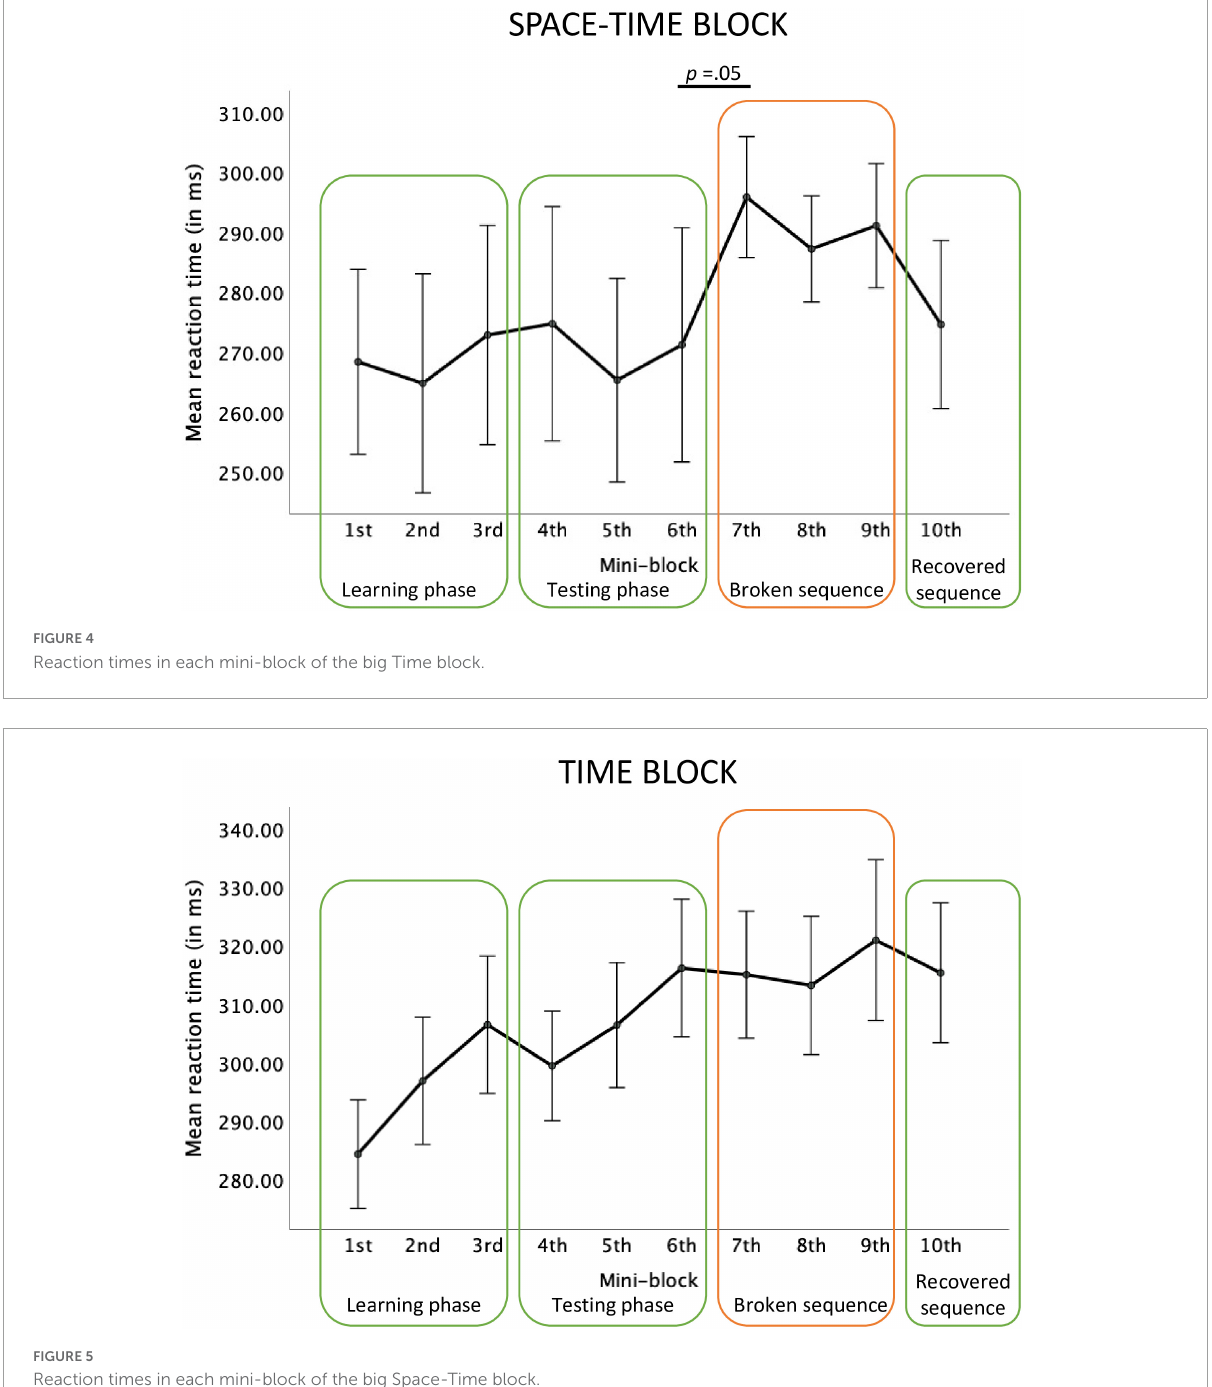
block was significant for the N2pc peak latency, [ F (3,42) = 4.82, p = 0.006, η p2 = 0.25, observed power = 0.87] as well as for the N2pc peak amplitude [ F (3,42) = 4.23, p = 0.011, η p 2 = 0.23, observed power = 0.82]. Simple contrast analysis with Random block as the reference category revealed shorter N2pc latency in